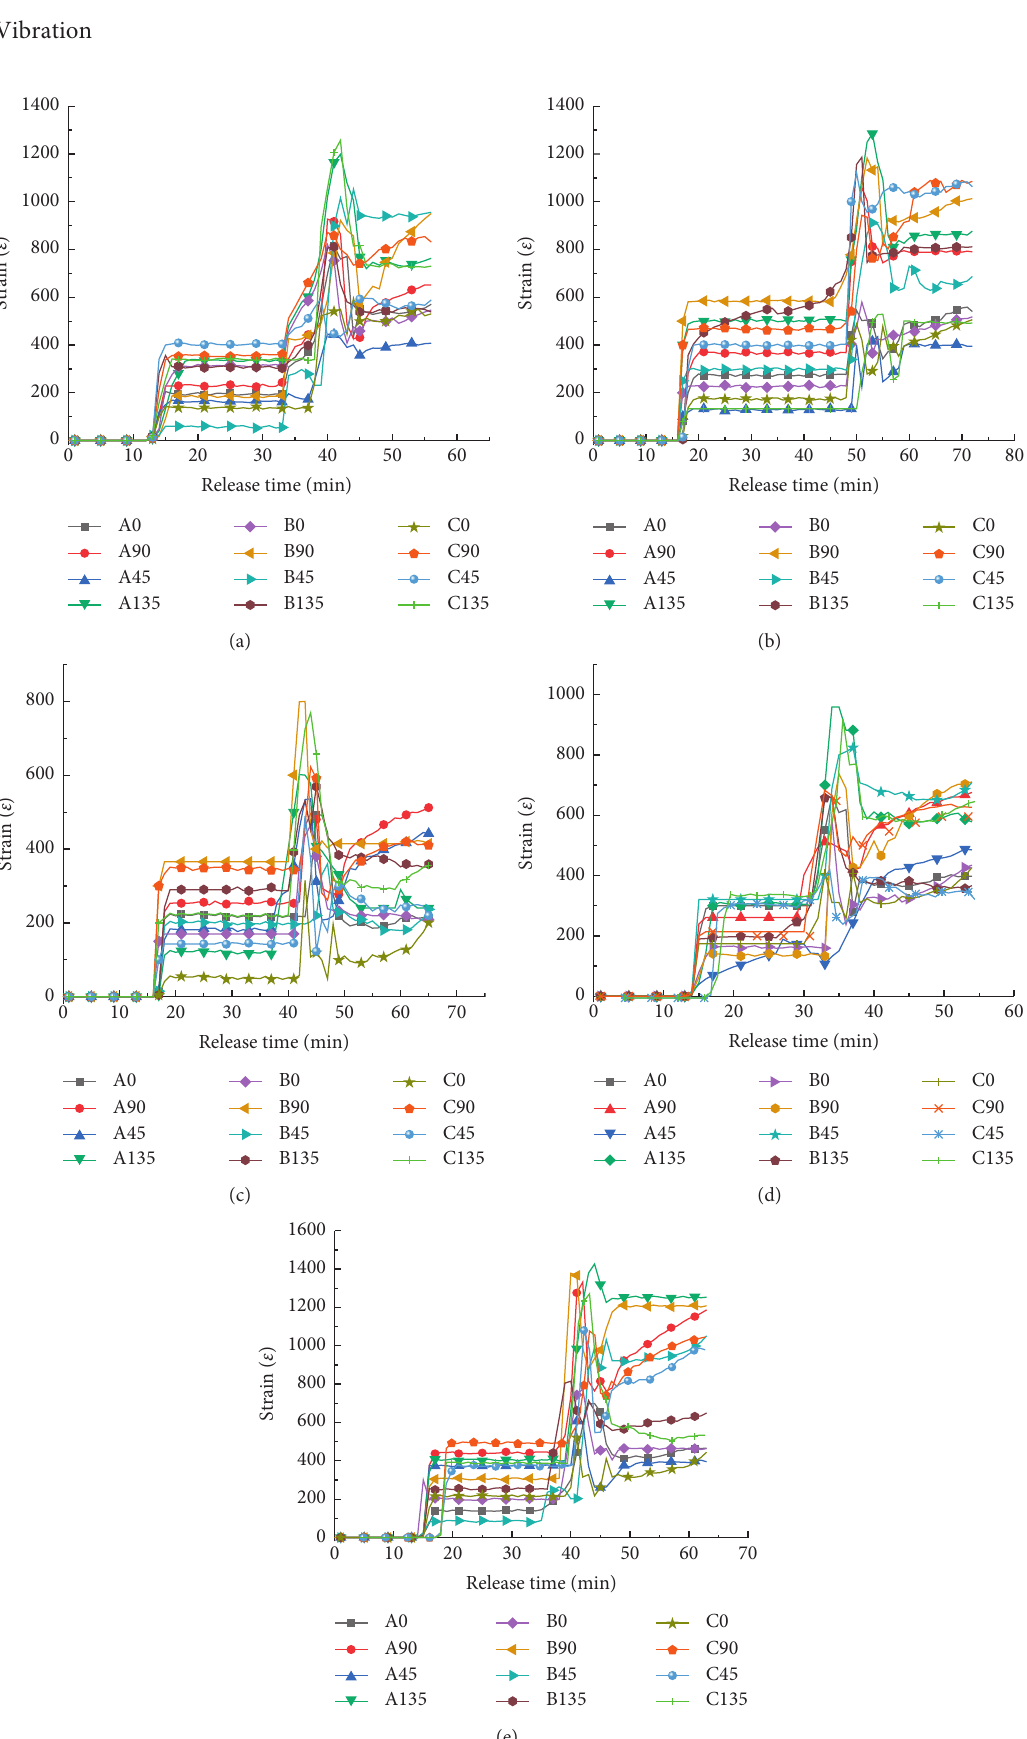
Figure 6: Stress relief curve of each measuring point. (a) Measuring point 1. (b) Measuring point 2. (c) Measuring point 3. (d) Measuring point 4. (e) Measuring point